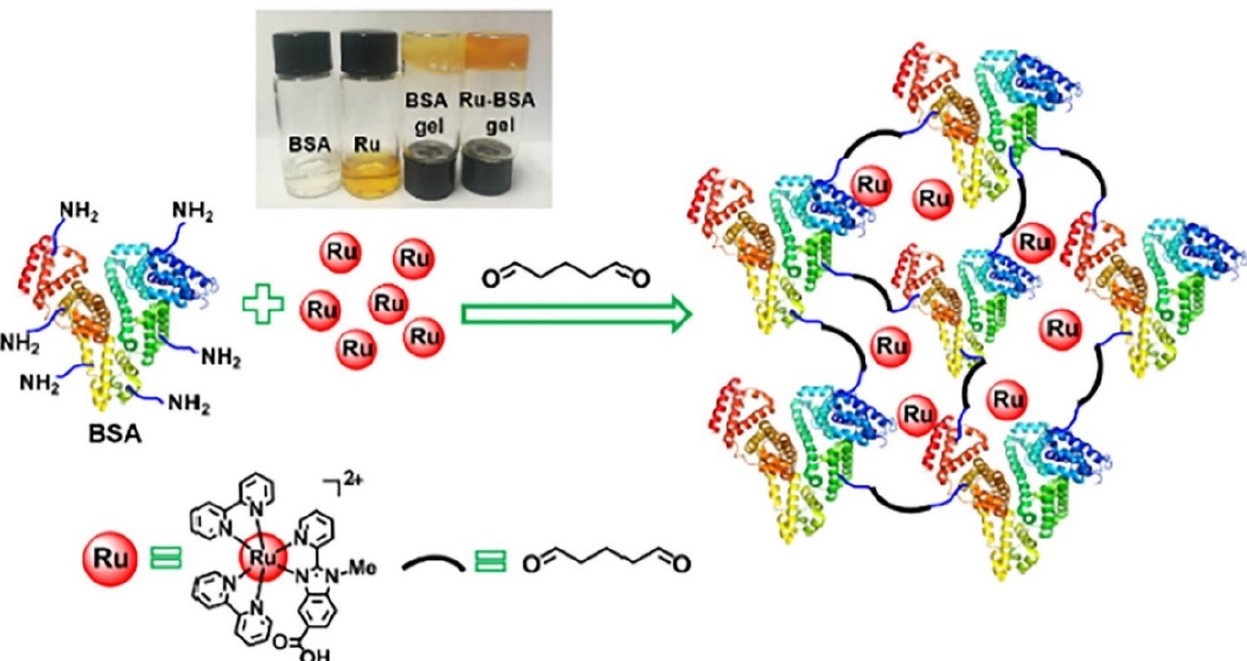
Figure 1. The schematic diagram of the Ru-BSA hydrogel. Reprinted from Reference [49] with permission from Elsevier. License Number: 5156040156264.